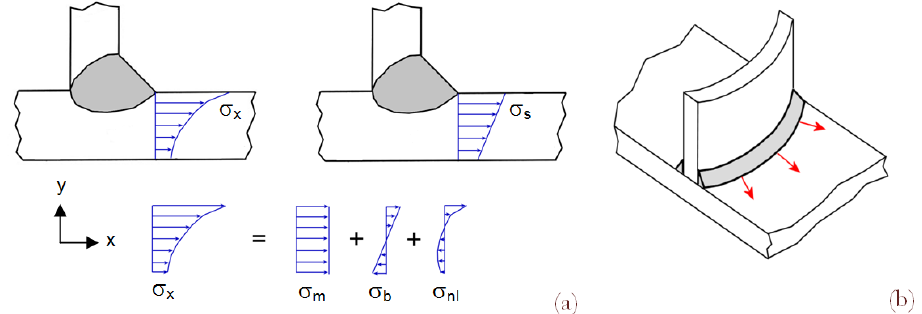
Figure 1: a) Decomposition of the through thickness stress at the weld toe; b) stress component acting normal to the weld